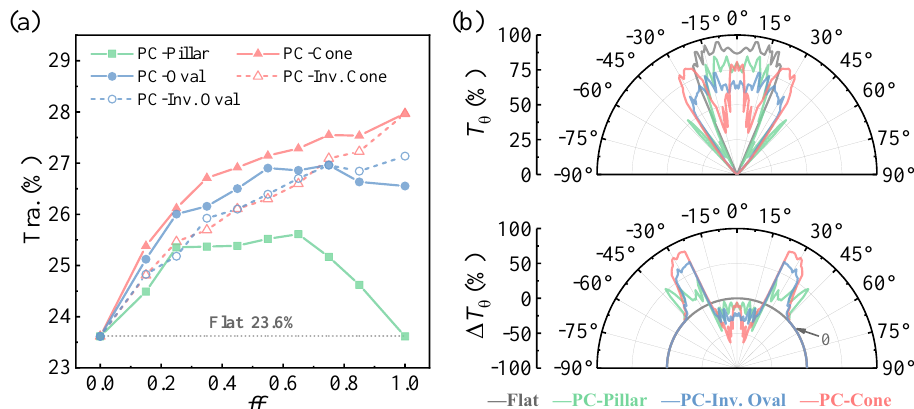
Figure 3. ( a ) The average transmittance Tra. of the related cases as a function of fill factor ff , where the respective optimal period P and height H were adopted. ( b ) The dependence of incident angle θ on transmittance T θ . The difference between PC structures and the flat counterpart Δ T θ was also presented as a comparison.